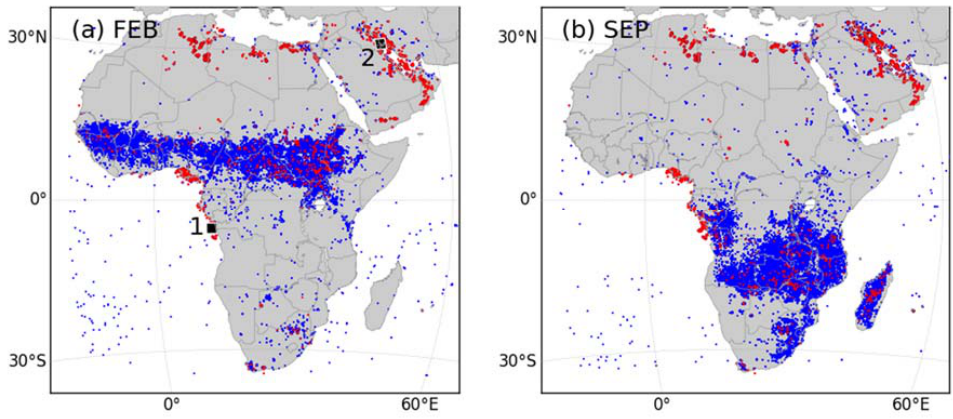
Figure 5. Locations of VIIRS-detected hotspot pixels over Africa and the Middle-East within the VIIRS NightFire product [20], for ( a ) February 2015 and ( b ) September 2015, coloured by the effective subpixel hotspot temperature derived via the multi-spectral Planck function fitting approach described in [20]. Blue points indicate hotspot effective temperatures < 1600 K, whilst red points indicate ≥ 1600 K. The latter appear to be associated primarily with the well-known gas flaring regions in the Middle East, North Africa and West Africa, whereas the former are associated mainly with the locations of seasonal landscape biomass burning (e.g., matching those regions shown as burning in [10] at these times of year). Locations 1 and 2 shown in ( a ) represent the ROIs used in the analyses undertaken in Section 3 and in Appendix A1